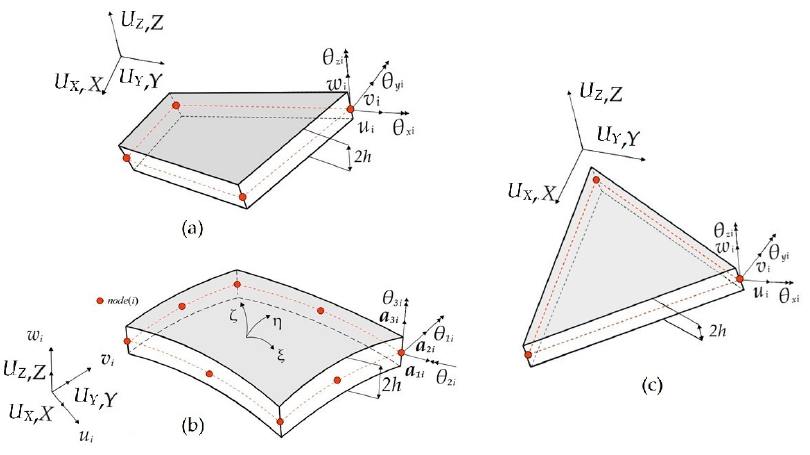
Figure 1. Geometries of ( a ) iQS4, ( b ) iCS8, and ( c ) iMIN3 inverse-shell elements with associated global and local coordinate systems as translational and rotational degrees of freedom (DOF).